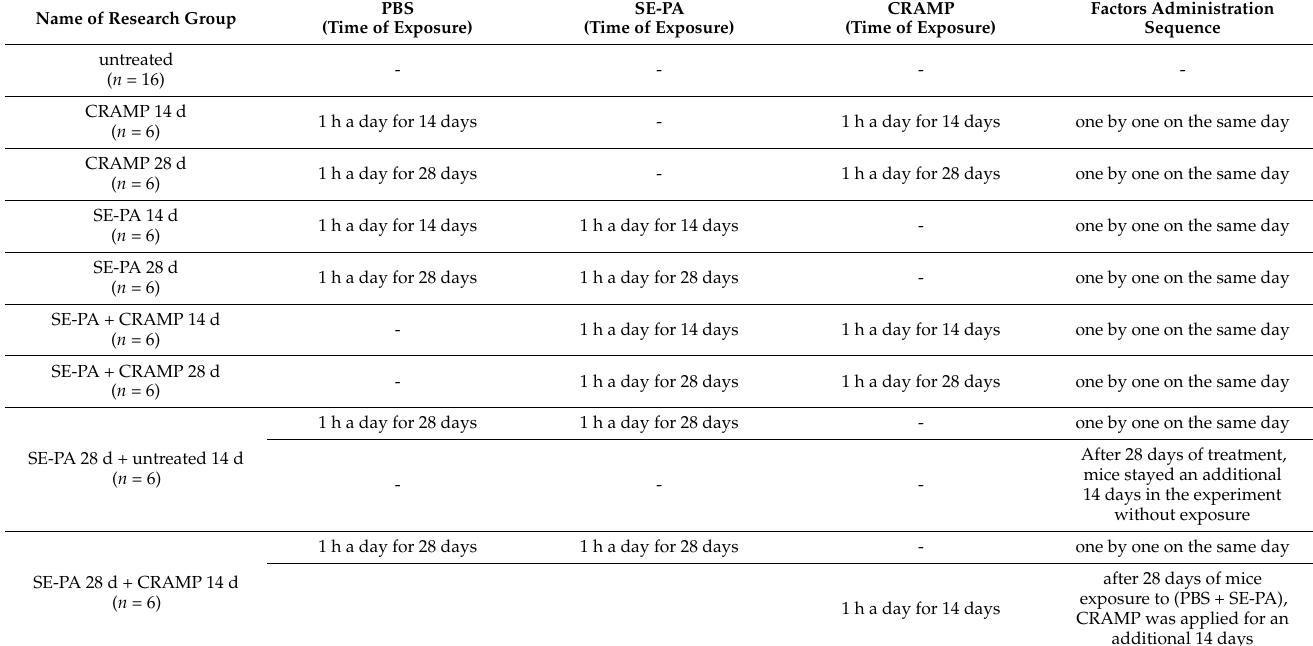
Table 3. The research group